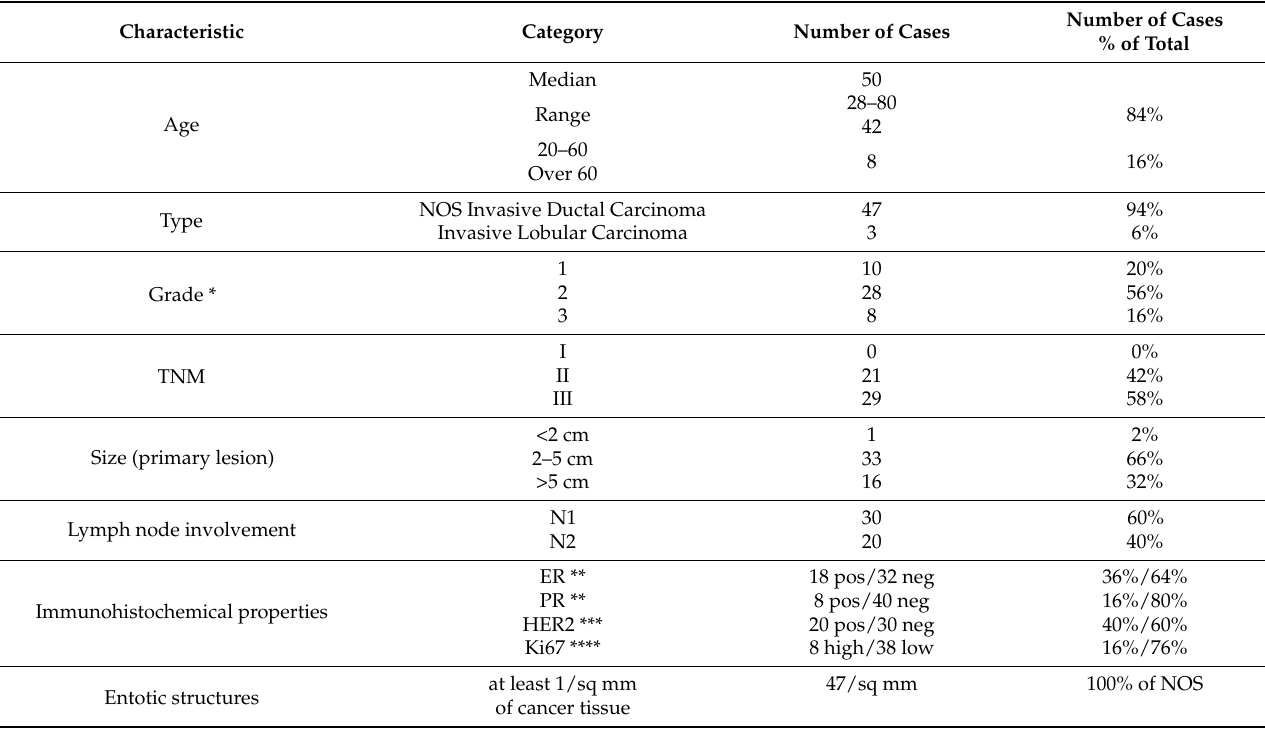
Table 1. Characteristics of the cohort of breast cancer